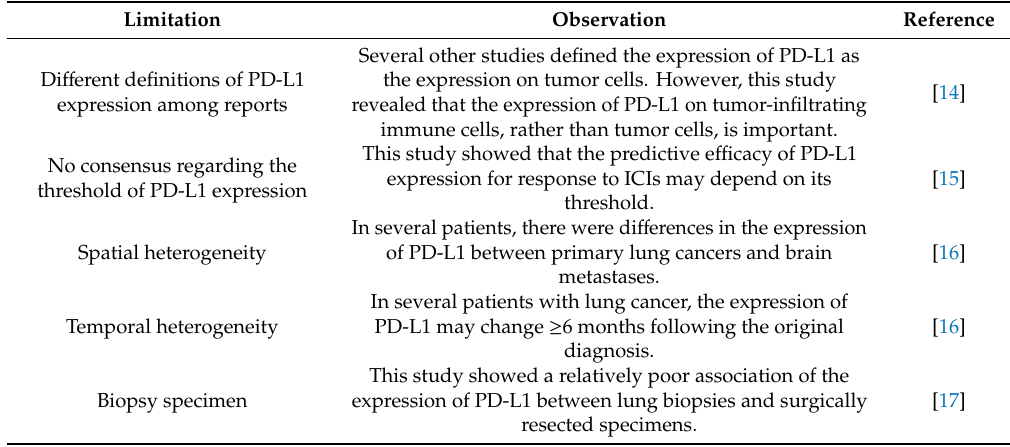
Table 2. Clinical reports showing the important limitations of PD-L1 expression as a